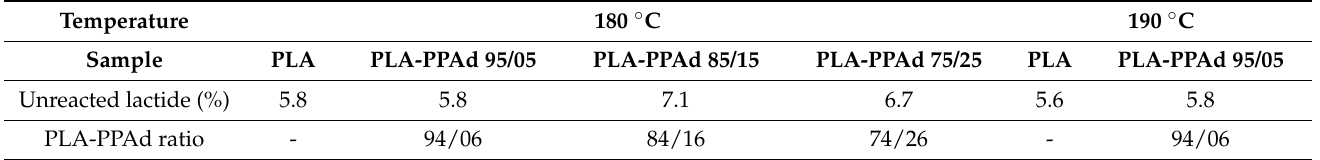
Table 2. Unreacted lactide and comonomer molar ratios calculated by